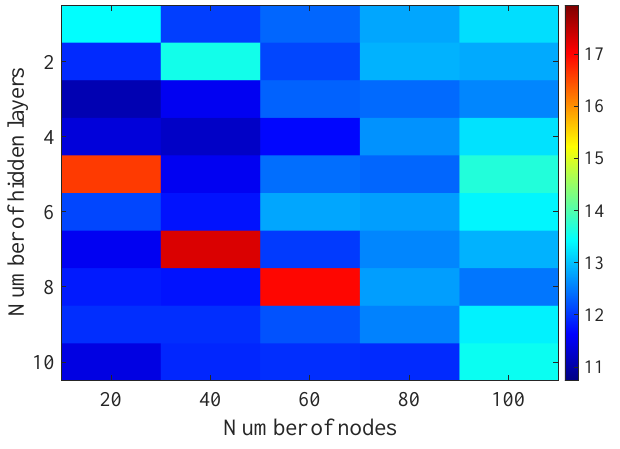
Figure 16. Matrix of the BLER RMSE metric predictions for the radio parameters history window W = 15 in the second stage learning process.